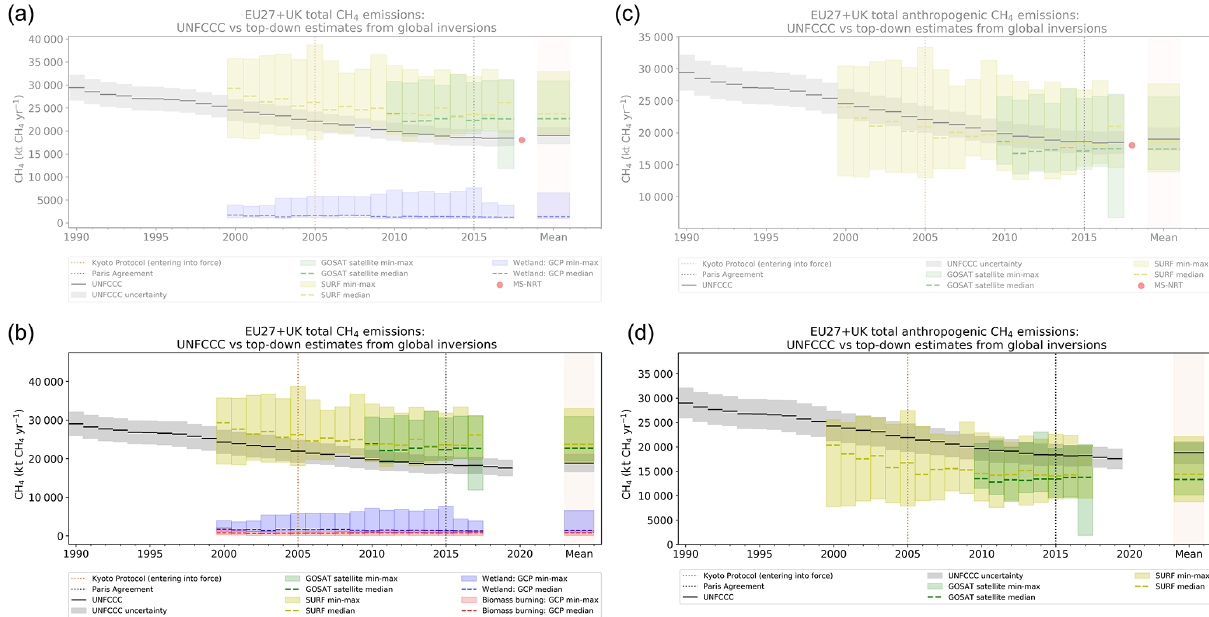
Figure 6. (a, b) Total CH 4 emissions from TD global ensembles based on surface station data (SURF) (yellow) and satellite concentration observations (GOSAT) (green) from 22 global models compared with UNFCCC NGHGI (gray) data (including LULUCF) as follows: (a, c) previous data from Petrescu et al. (2021) and (b, d) the current study. (c, d) Anthropogenic CH 4 emissions from top-down global inversions based on surface stations (SURF) (yellow) and on satellite concentration observations (GOSAT) (green) from different estimates as follows: (c) previous data from Petrescu et al. (2021) and (d) the current study. Anthropogenic emissions from these inversions were obtained by removing the sum of the natural emissions (global wetland GCP emissions (blue), the inland waters and geological fluxes as shown in Fig. 4a) from the total estimates. The biomass burning emissions included in each inversion result were removed as well. UNFCCC NGHGI (2021) member-state-reported uncertainty computed with the error propagation method (95% confidence interval) was gap-filled and provided for every year for all sectors (including LULUCF). The time series mean was computed for the common period of 2010–2016. Two out of 11 SURF products (GELCA-SURF_NIES, TOMCAT-SURF_UOL) were not available for